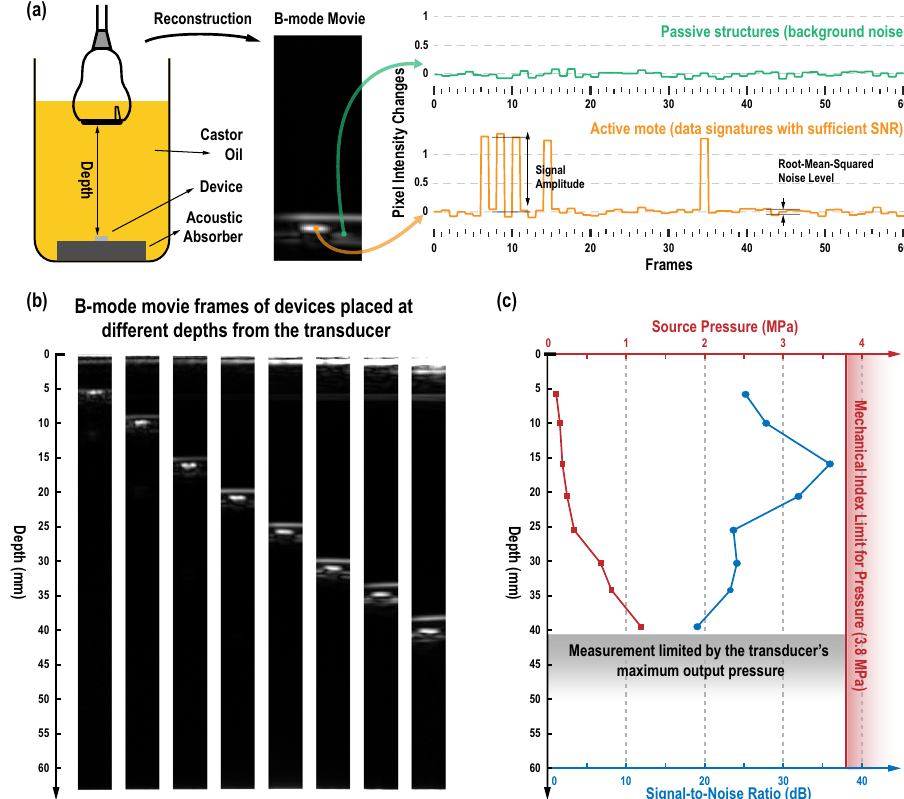
Fig. 5 Characterization of the mote in a controlled ultrasound environment. a Experimental setup and pixel intensity changes at passive structures and the active mote across frames in the reconstructed B-mode movie; b B-mode movie frames for depth characterization; and c the minimum source pressure required to properly power the mote at these depths and the detected signal-to-noise ratio in the corresponding B-mode